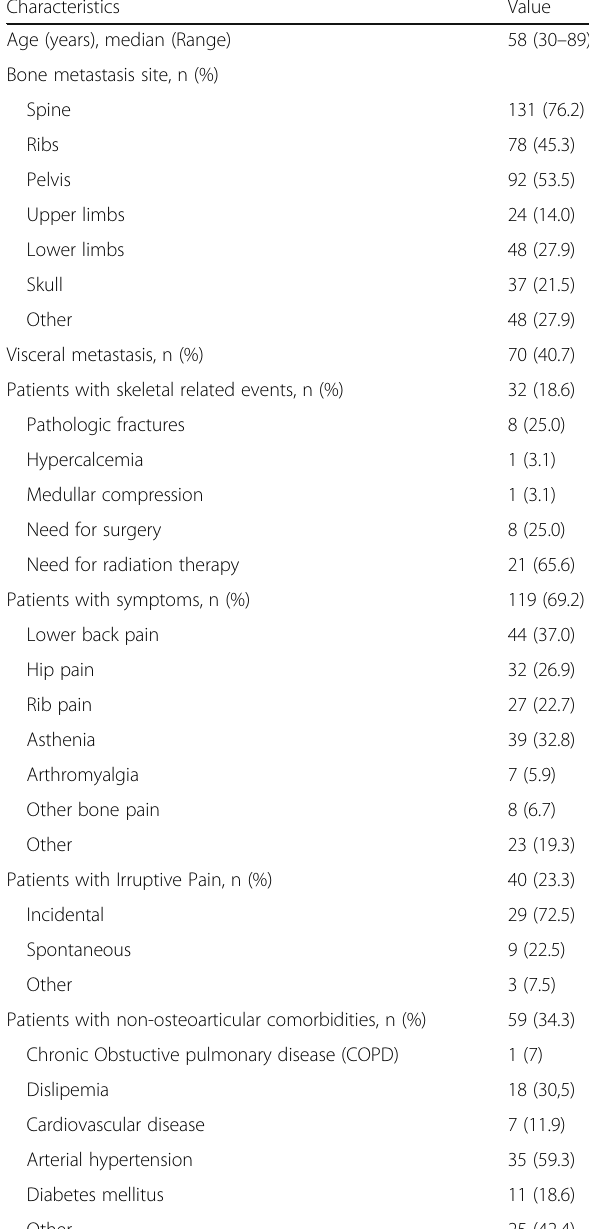
Table 1 Baseline patient characteristics ( n = 172)